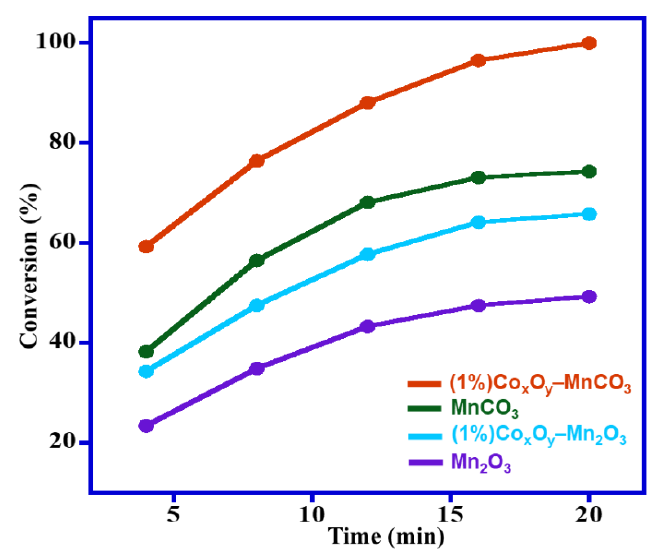
Figure 5. GraphicalillustrationofBzOHoxidationovercatalystscalcinedat300 ◦ C(i.e.,(1%)Co x O y –MnCO 3 Figure 5. Graphical illustration of BzOH oxidation over catalysts calcined at 300 °C (i.e., (1%)Co x O y – and MnCO 3 ) as well as the catalysts calcined at 500 ◦ C (i.e., (1%)Co x O y –Mn 2 O 3 and Mn 2 O 3 ). MnCO 3 and MnCO 3 ) as well as the catalysts calcined at 500 °C (i.e., (1%)Co x O y –Mn 2 O 3 and Mn 2 O 3 ).